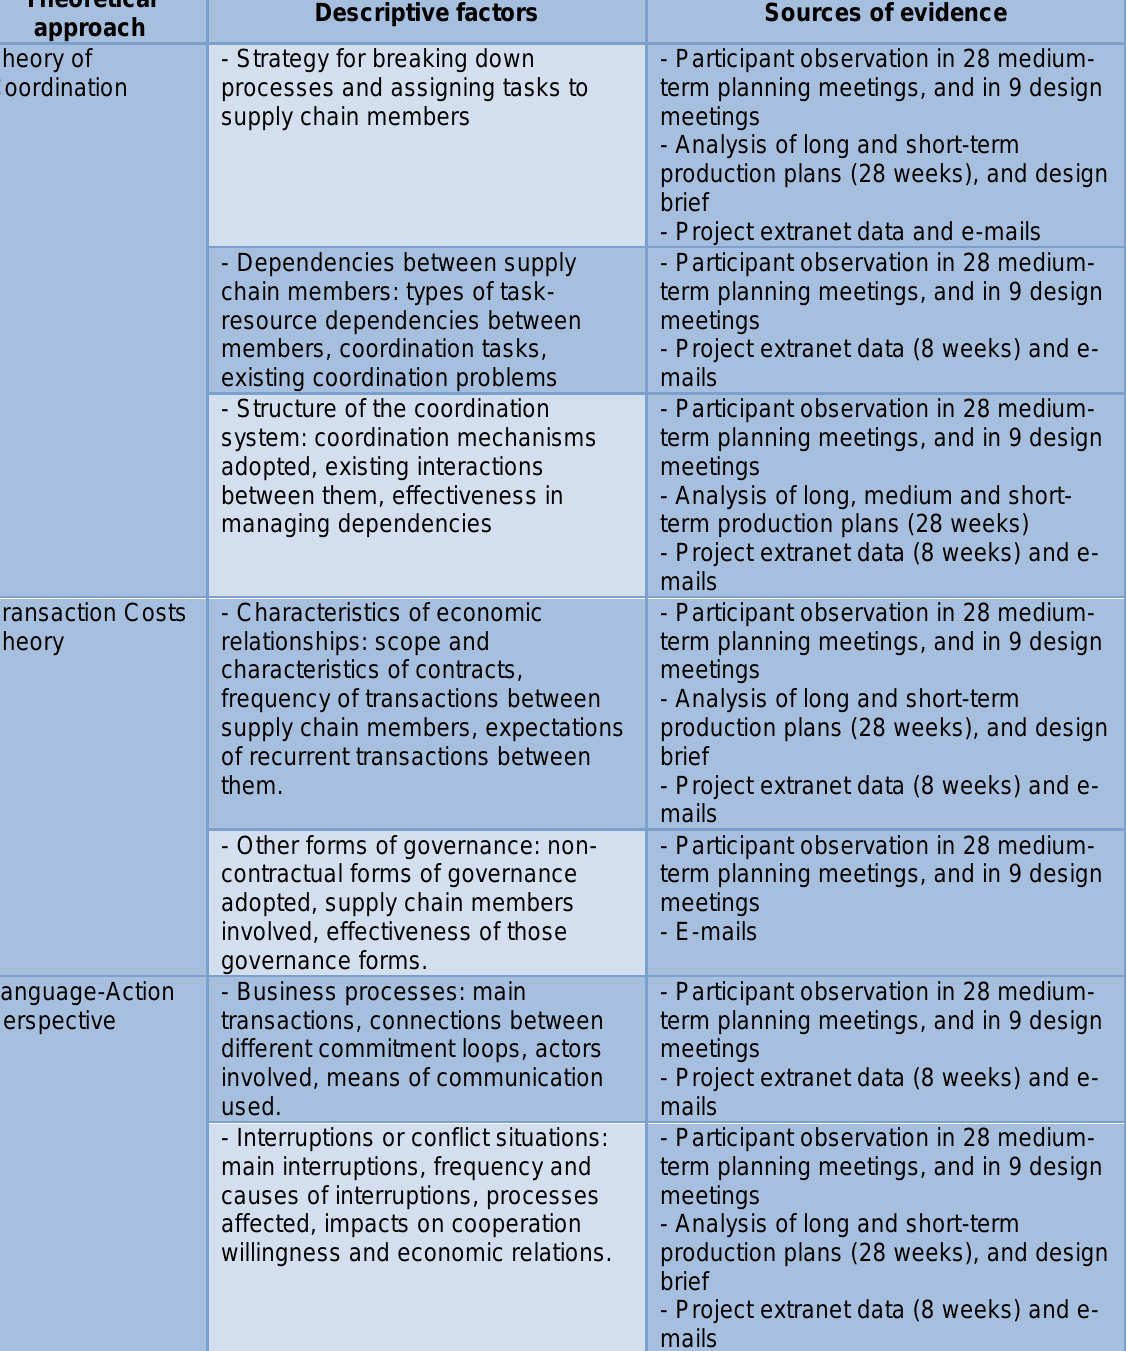
Table 6 Descriptive factors adopted and sources of evidence Note: project extranet data includes the number of accesses, frequency of document uploads and downloads, content of electronic documents and